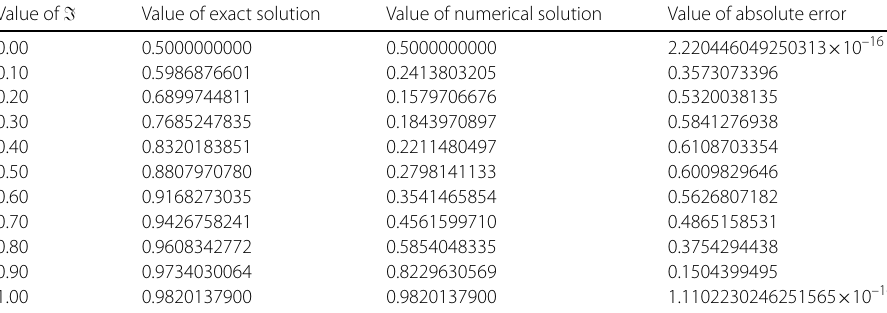
Table 2 Comparison between analytical and numerical solutions of the Cahn–Allen equation to discuss the absolute error between both of them that explains the convergence between these solutions Value of (cid:6) Value of exact solution Value of numerical solution Value of absolute